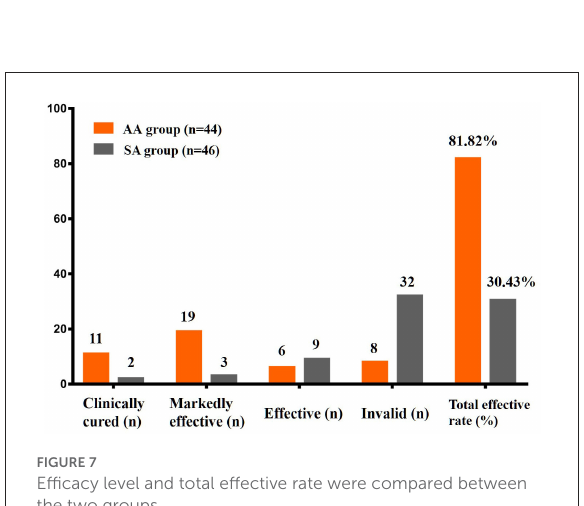
FIGURE7 Efficacy level and total effective rate were compared between the two